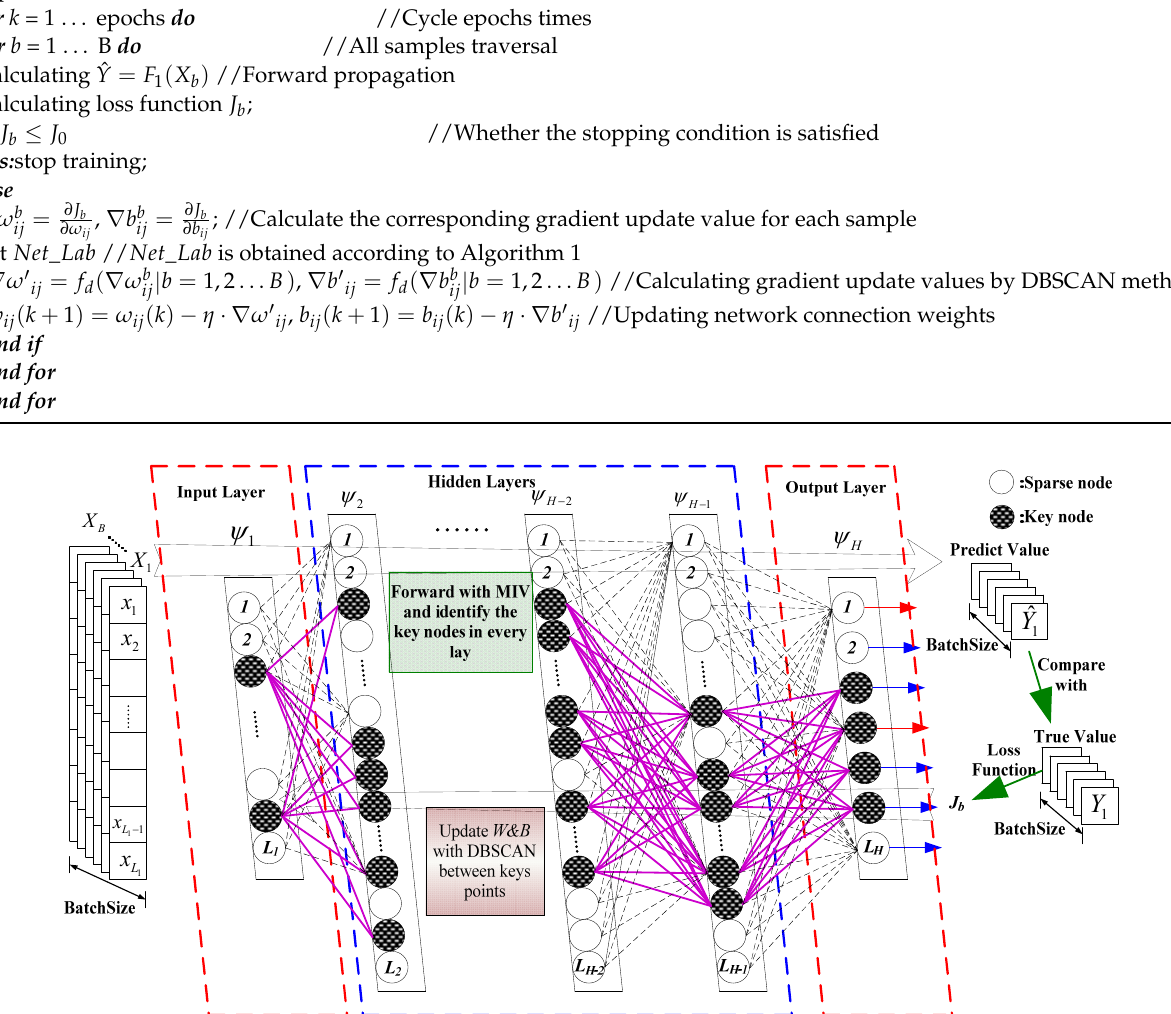
= ( x ) . , ,..., X X X and 1 , x 2 ,. . ., x l ,. . ., x L 1 1 1 2 B